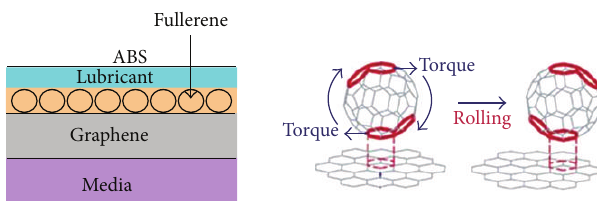
Figure 42: A schematic of the HDI with fullerene buffer layer between the PFPE lubricant and graphene. The motion of the fullerene on graphene can provide additional